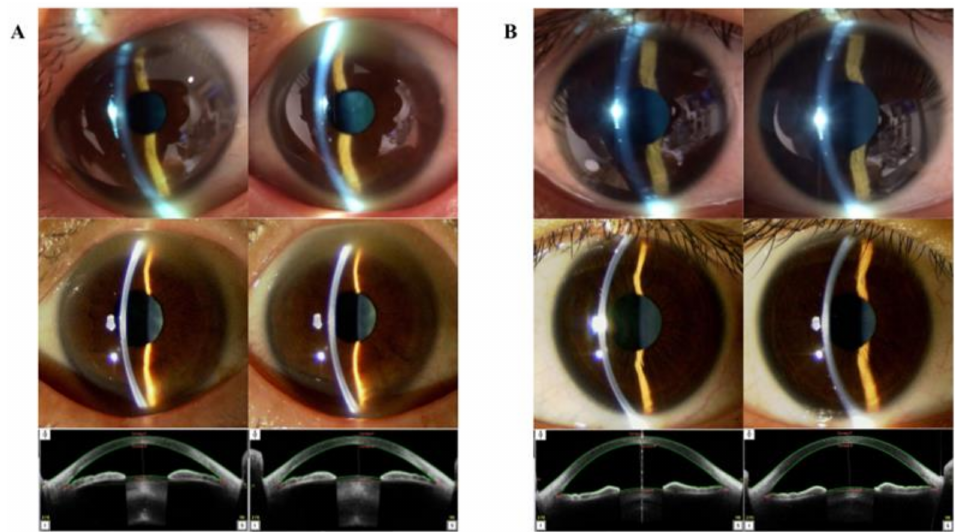
Figure 3. Case presentation. ( A ) Ophthalmological images of a 62-year-old Asian man. The upper-tier images were obtained using the smart eye camera (AC: shallow/shallow, Van-Herick Plus grade: 3/3). The middle-tier images were obtained using conventional slit-lamp microscopy (AC shallow/shallow, Van-Herick Plus grade: 3/3). The bottom-tier images were obtained using AS-OCT (ACD: 2.481/2.484 mm, TIA: 21.3/20.4 ◦ ). ( B ) Ophthalmological images of a 32-year-old Asian woman. The upper-tier images were obtained using the smart eye camera (AC: deep/deep, Van-Herick Plus grade: 4/4). The middle-tier images were obtained using the conventional slit-lamp (AC deep/deep, Van-Herick Plus grade: 4/4). The bottom-tier images were obtained using AS-OCT (ACD: 3.415/3.388 mm, TIA: 66.7/61.9 ◦ ). AS-OCT: anterior-segment optical coherence tomography, ACD: anterior chamber depth, TIA: trabecular-iris angle.